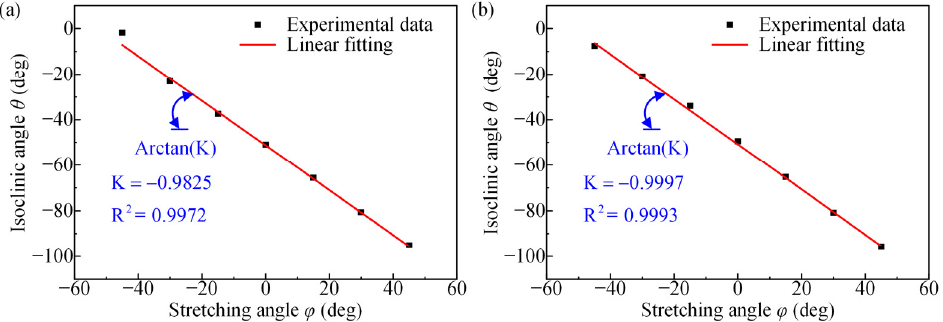
Figure 7. The relation between the isoclinic angle and stretching angles of PET films in ( a ) transmission photoelastic experiments and ( b ) reflection photoelastic experiments.